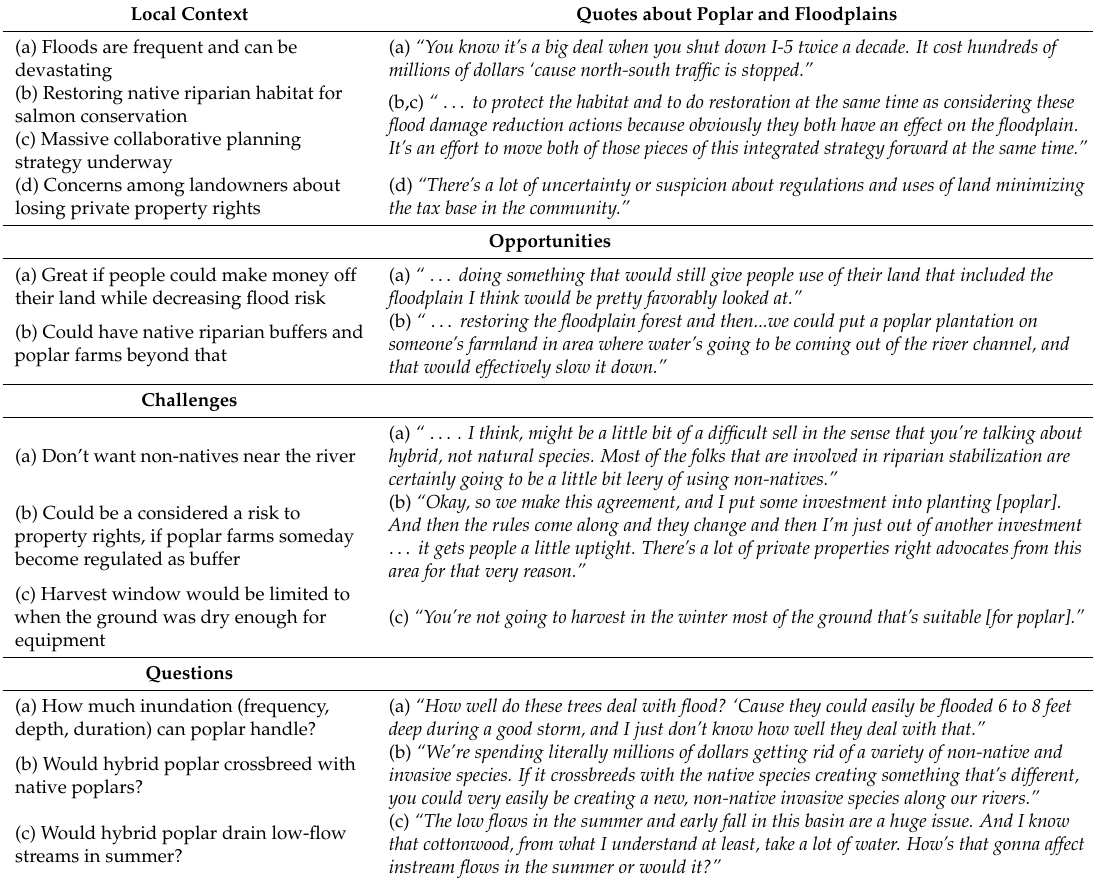
Table 5. Summary and quotes related to the potential for poplar to provide ecosystem services for floodplain management in flood-prone southwestern Washington, from participant stakeholders in agriculture and natural